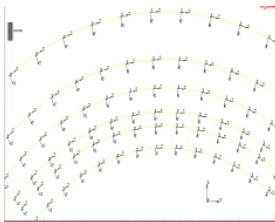
Figure 4. Welding path